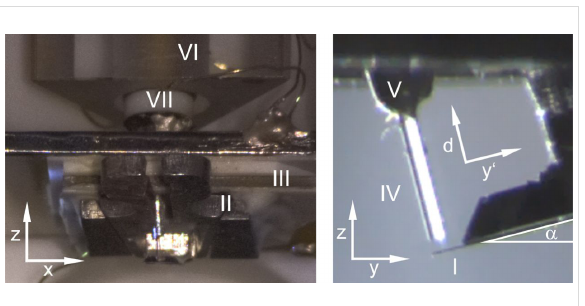
Figure 1: Details of the NC-AFM measuring head in a front and side view showing the interferometric setup with the cantilever, I, mounted on a dove-tail cantilever holder, II, inserted in a holding mechanism on the piezo stage, III. The fiber, IV, is mounted in the ferrule, V, glued in the tube piezo, VII, used for fine-positioning and scanning the fiber. The tube-scanner piezo is embedded in the sapphire prism, VI,